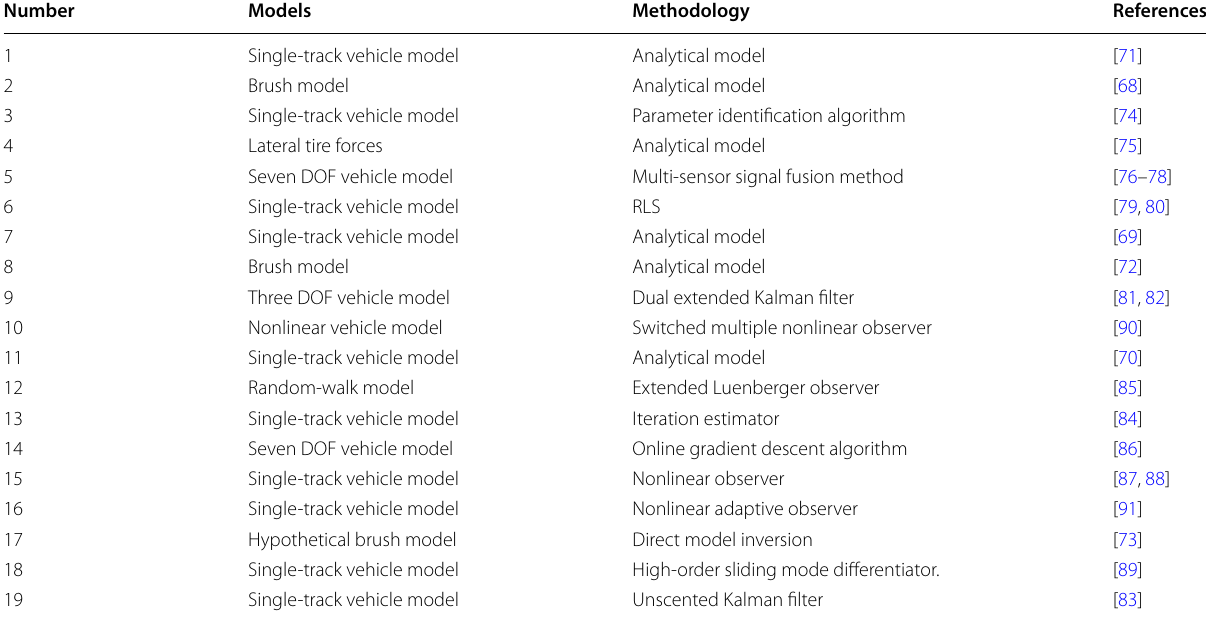
Table 2 Summary of estimation methods based on vehicle lateral dynamics Number